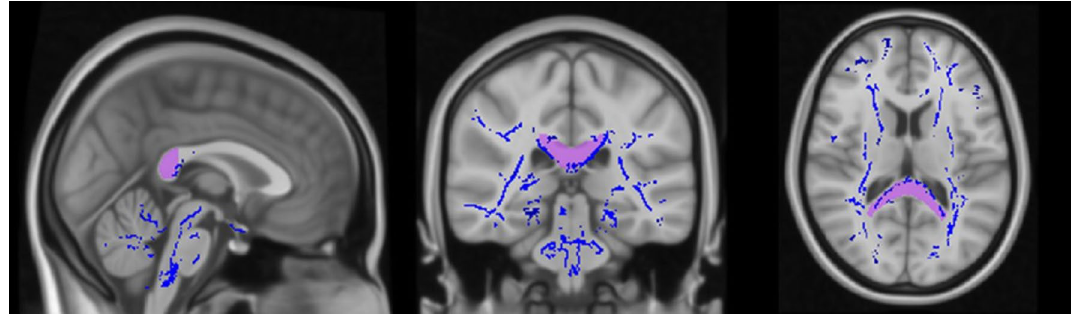
Fig. 8 Splenim (displayed in purple) of corpus callosum showing statistically significant ( p value < 0.001) higher mean FA value in ASD group compared to TDC group displayed in blue